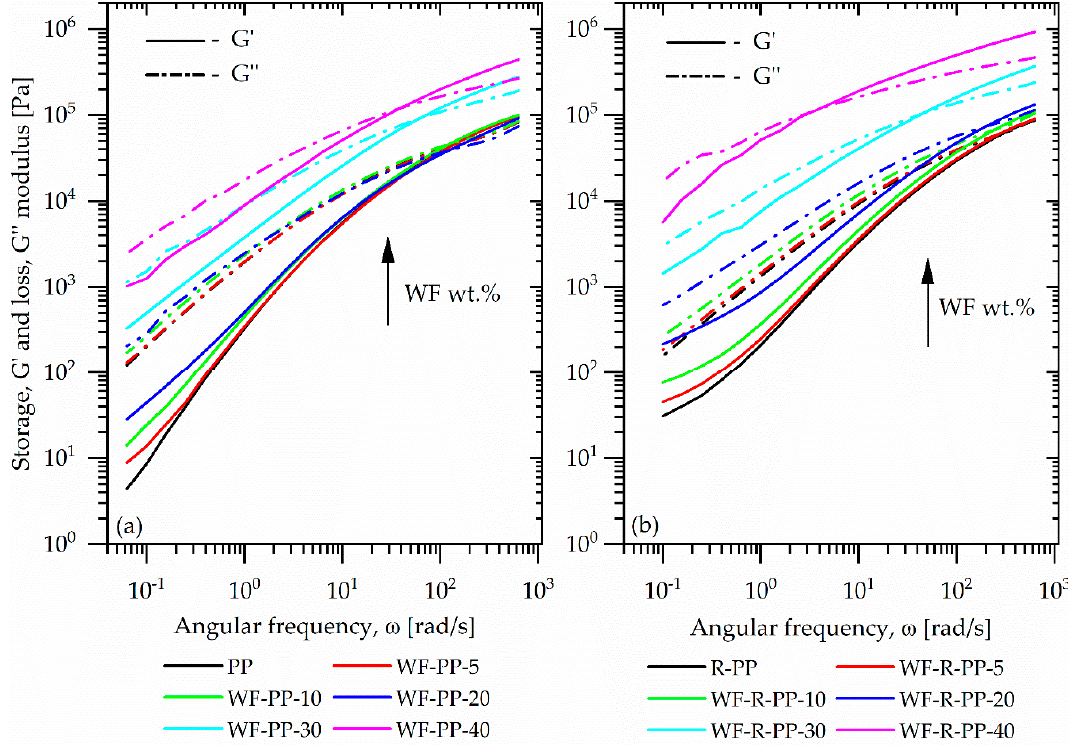
Figure 9. Storage G’ and loss G’’ modulus as a function of angular frequency at 190 °C for ( a ) unrecycled material and ( b ) recycled material in the linear viscoelastic region.